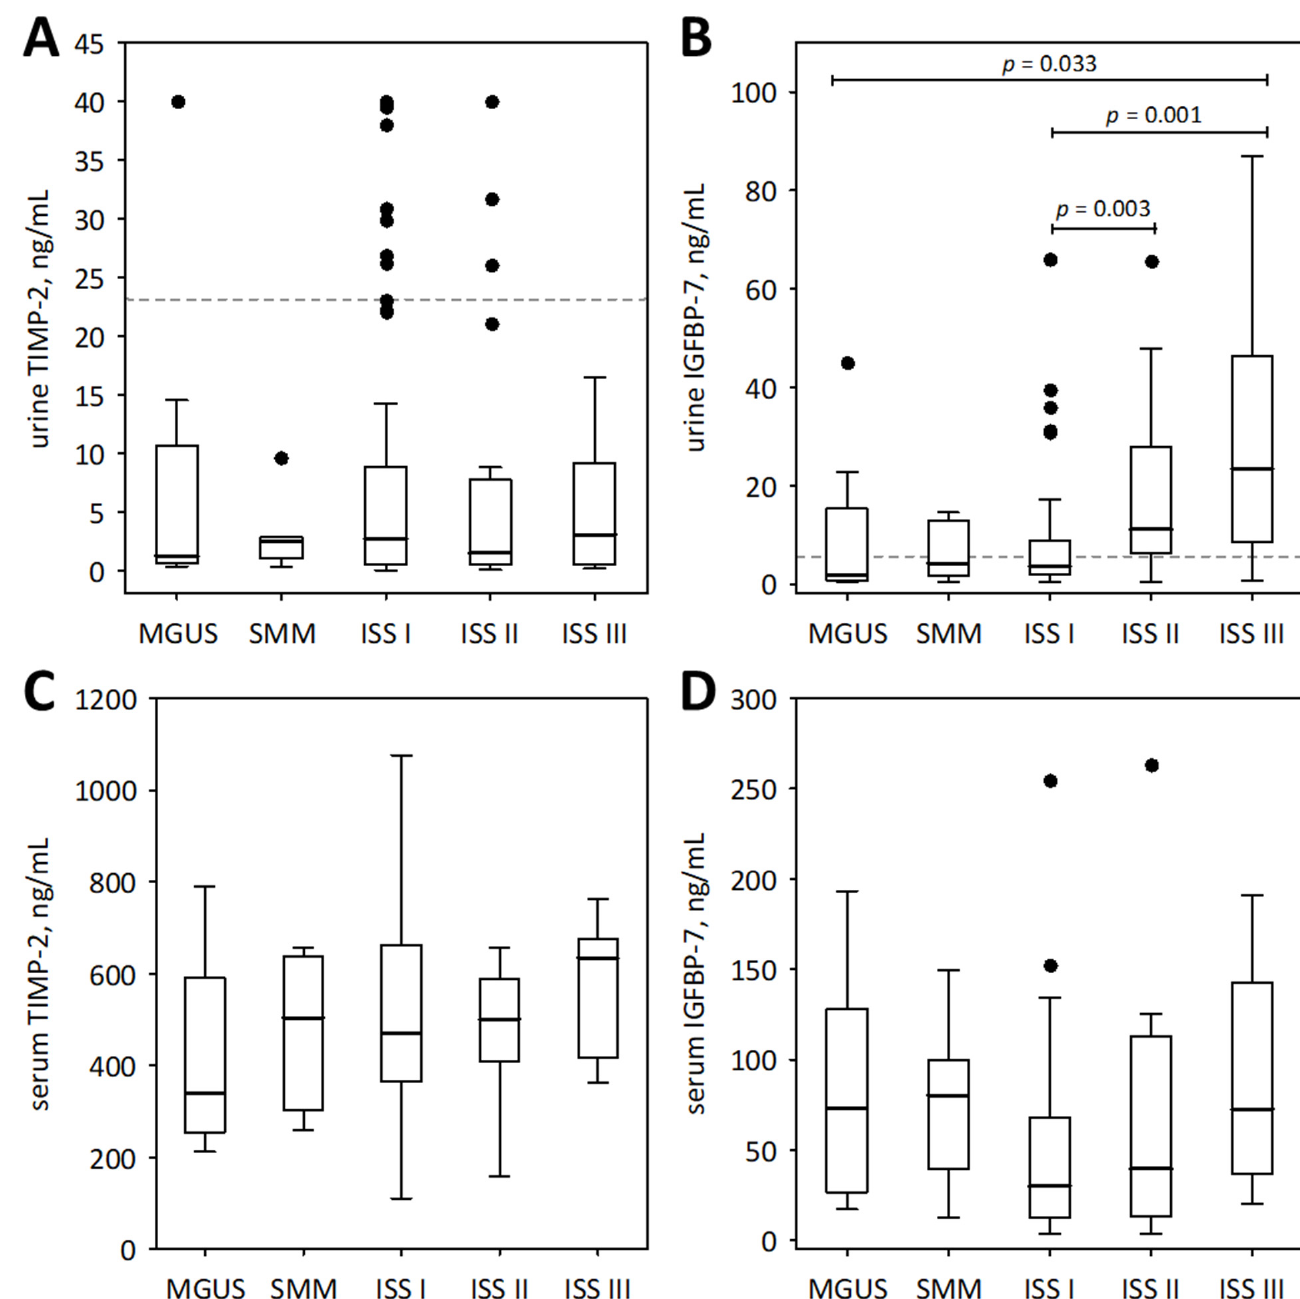
Figure 2. Urinary ( A , B ) and serum ( C , D ) concentrations of TIMP-2 ( A , C ) and IGFBP-7 ( B , D ) among patients with monoclonal gammopathy ranging from MGUS to symptomatic MM. Serum concentrations of the markers were assessed in a subgroup of 73 patients. Data are shown as the median (central line), interquartile range (box), and non-outlier range (whiskers). The outliers are shown as points. We report p -values for significant differences between groups (calculated in post-hoc tests following the Friedman ANOVA). The dotted lines in panels ( A , B ) indicate non-outlier maximum urinary concentrations of the markers obtained in the control group of 21 healthy individuals.